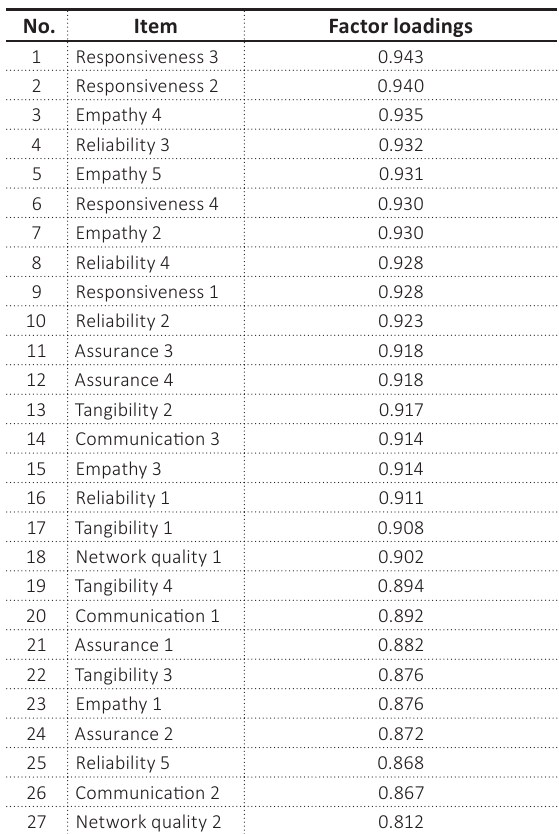
Table 2. Rotated component matrix